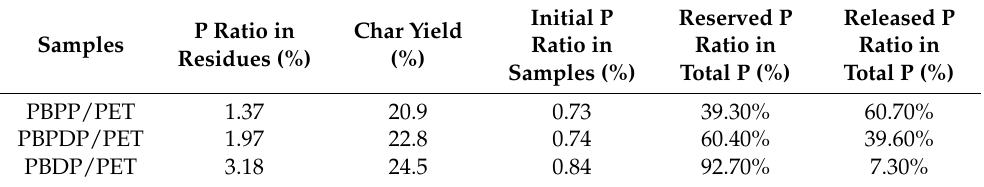
Table 4. Reserved and released P contents in cone calorimeter test by